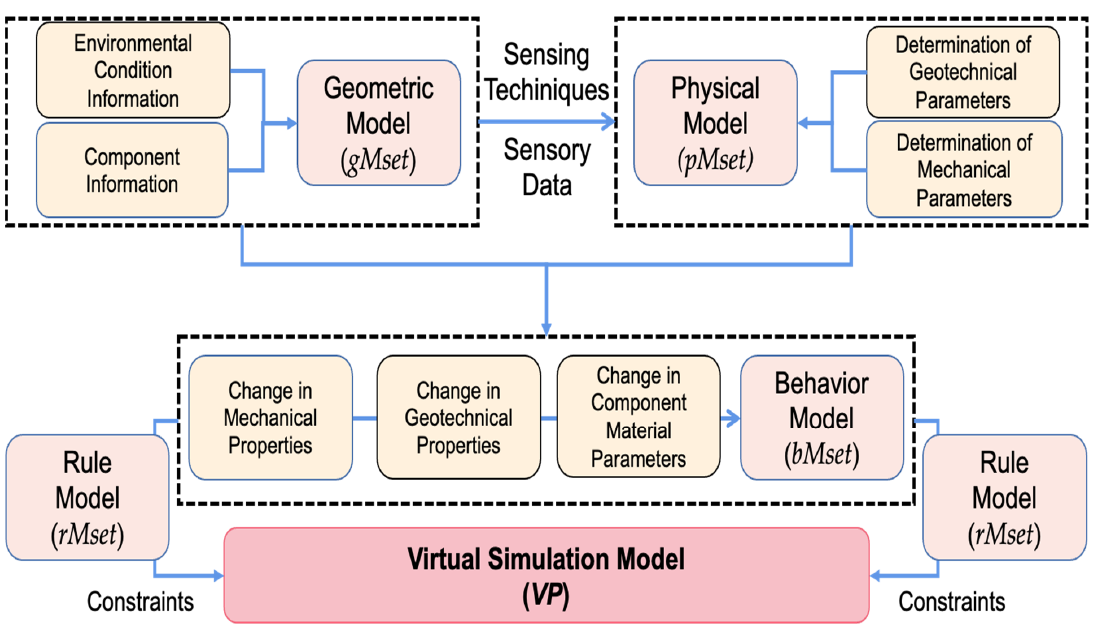
Figure 3. A process model for creating digital twin (DT) virtual simulation model.